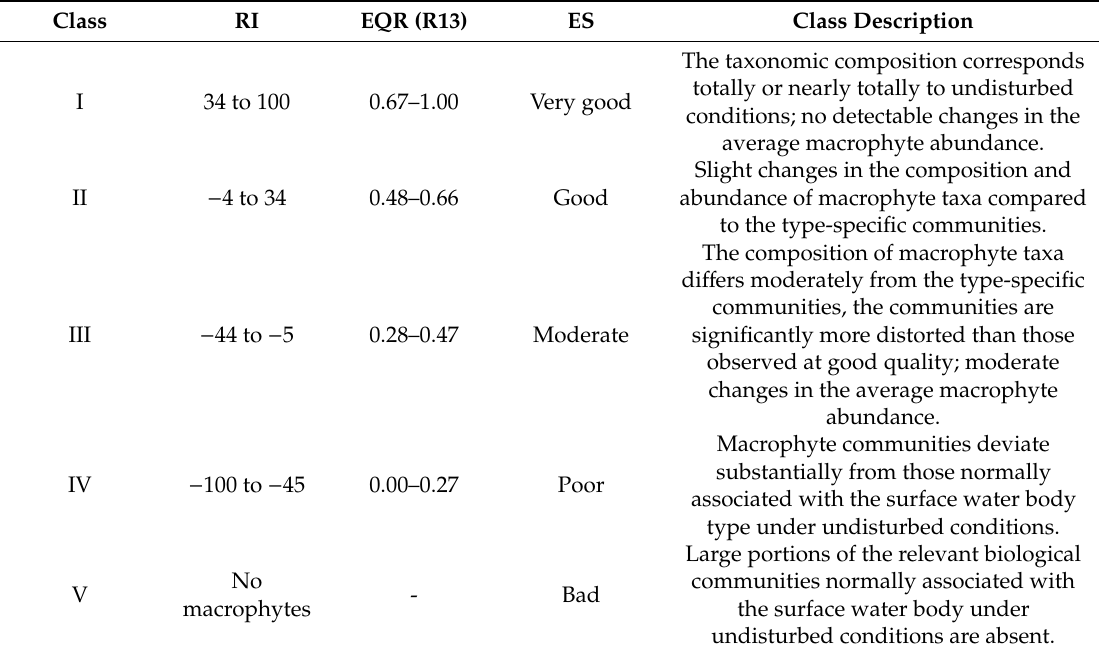
Table 4. Classification of ES according to RI-BG for rivers of type R13